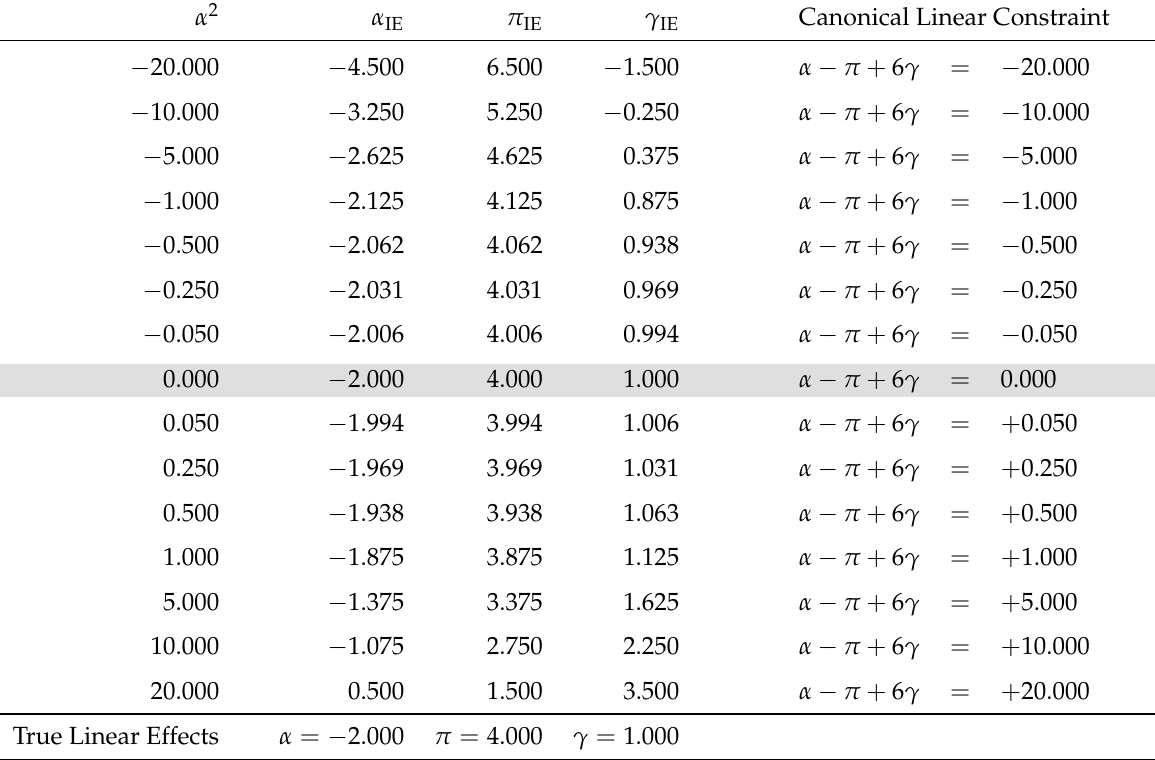
Table 10: Sensitivity of the IE